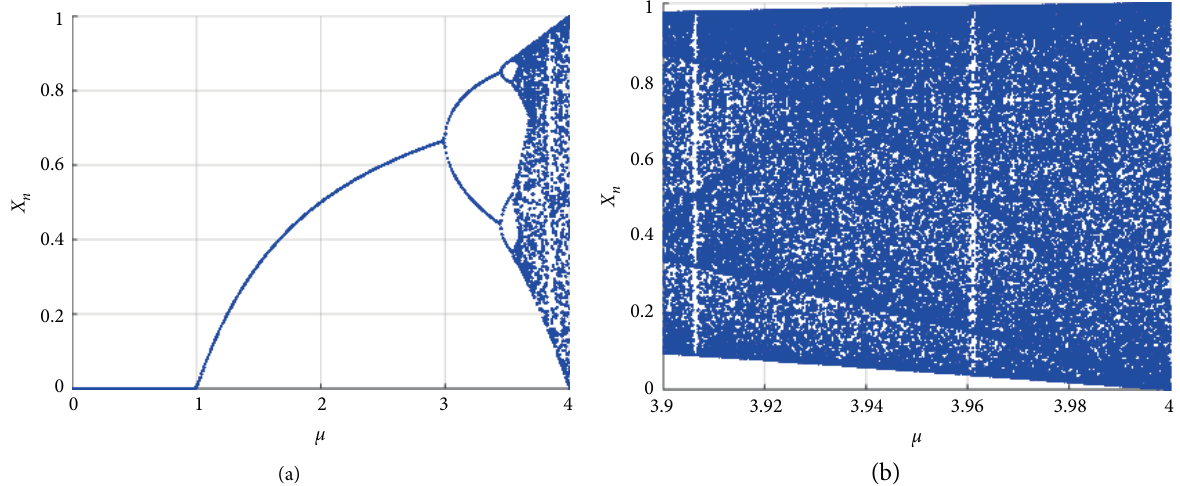
Figure 1: Bifurcation diagram of logistic map: (a) when